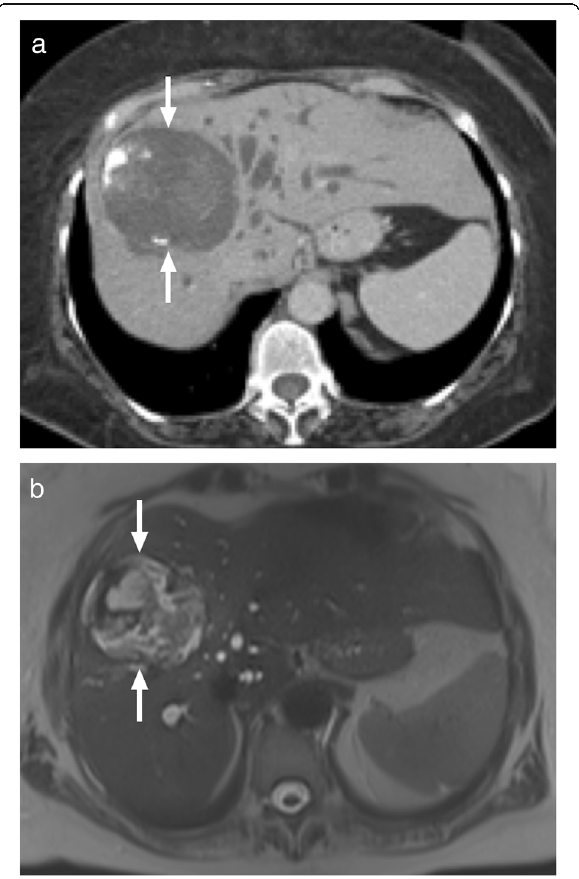
Fig. 3 A 77-year-old male farmer with no significant medical history presented with recently onset jaundice and right upper quadrant pain. a Axial plane postcontrast abdominal CT demonstrates a complex looking mass with heterogenous central part and peripheral calcifications (arrows). Also note dilatation of the intrahepatic bile ducts due to the mass effect of the lesion. b Axial plane T2W MR image demonstrates the cystic nature of the mass (arrows) with internal septations which may suggest detached eccinochocal membrane. There was no evidence of internal contrast enhancement on postcontrast dynamic T1W images (not shown). Percutaneous drainage confirmed hydatid